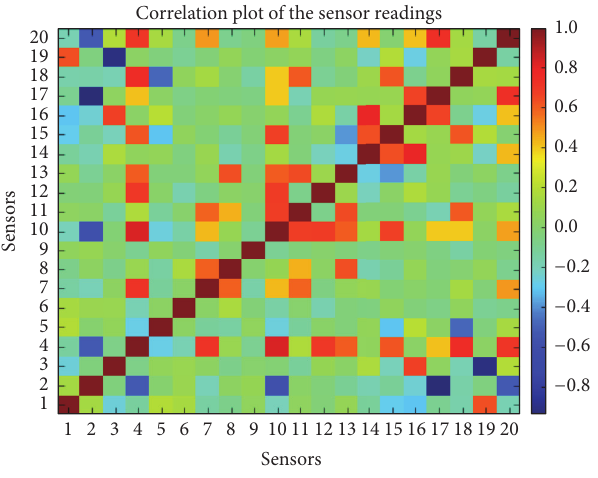
Figure 10: Pairwise correlations of the sensor readings. Table6:Rankingsoftop5sensorsbasedonreductioninproduction cost value (KPI-1).